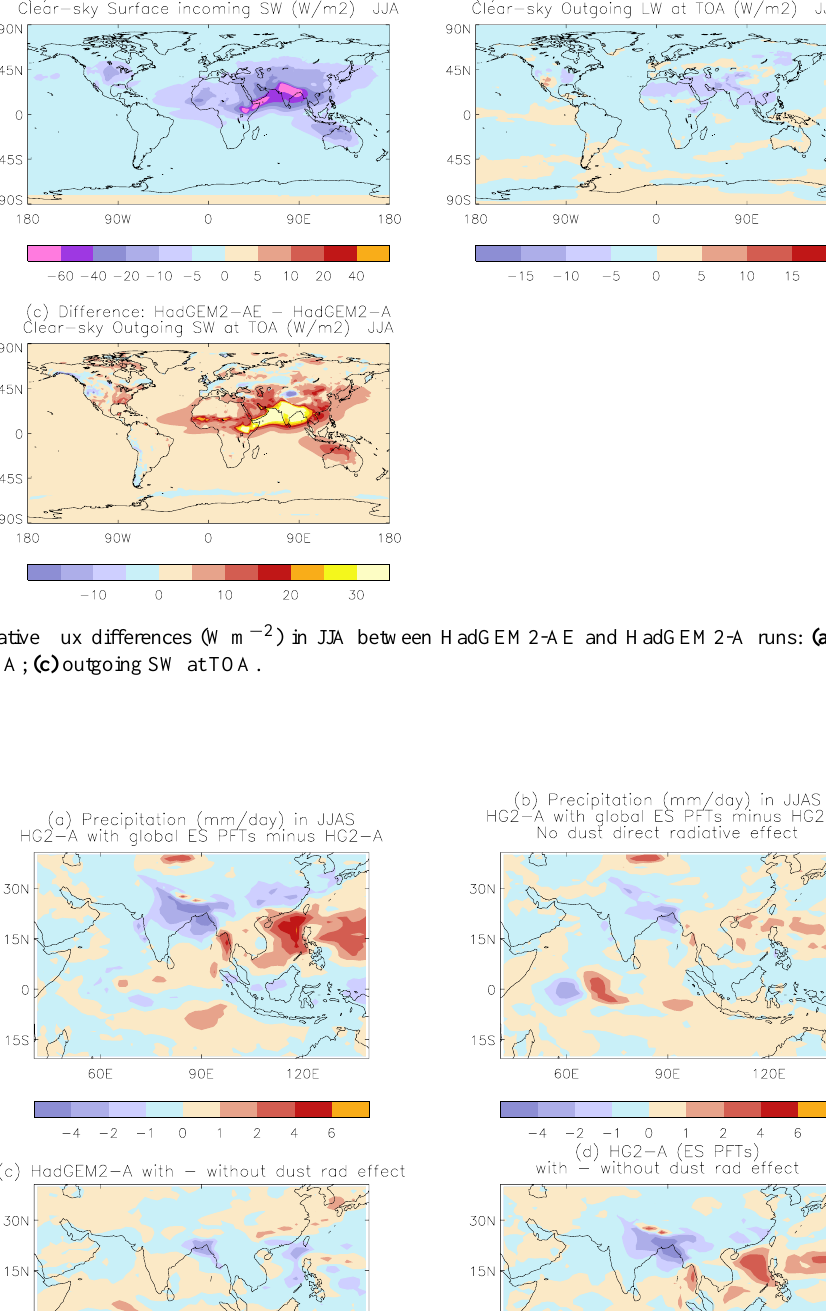
www.earth-syst-dynam.net/3/245/2012/ Earth Syst. Dynam., 3, 245–261,